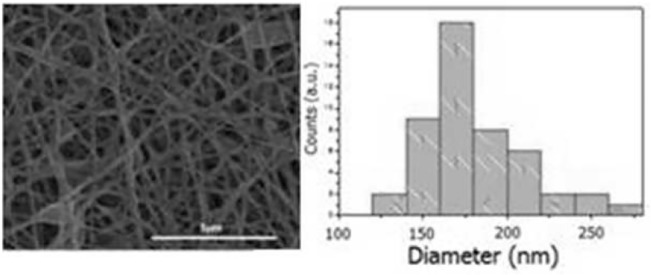
SEM Micrograph of the electrospun sample PCL-RGD-EAK 10%(wt), (a), and its diameters distribution, (b).The fiber diameter is ranging from 100 to 280 nm.